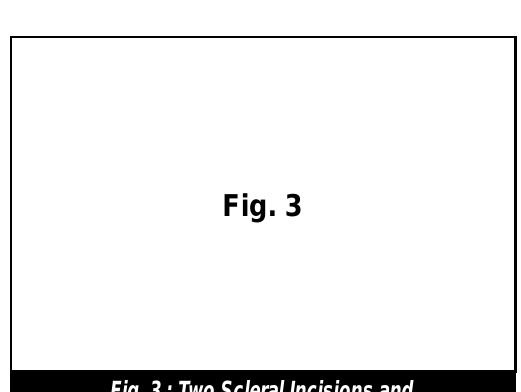
a Small Peripheral Iridectomy